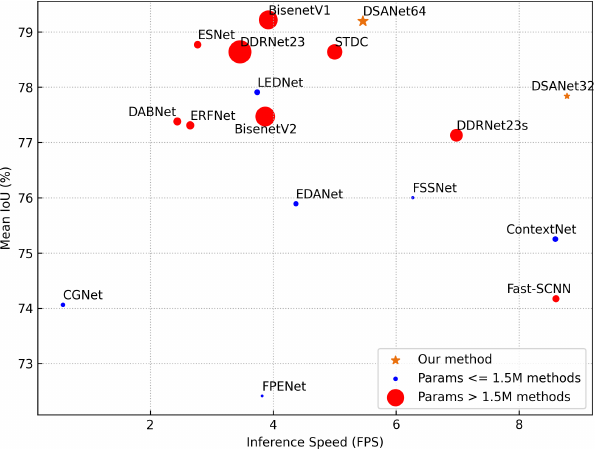
Figure 1. Speed-accuracy tradeoff yielded by different semantic segmentation methods on the ISPRS Potsdam dataset with a size of 6000 × 6000 pixels using an RTX 3090 GPU. Orange points: different versions of our proposed method. Red points: lightweight methods with more than 1.5 M parameters. Blue points: lightweight methods with less than 1.5 M parameters. Our proposed methods achieve the best speed-accuracy tradeoffs. It is worth noting that that the sizes of the corresponding points of the methods are positively correlated with their